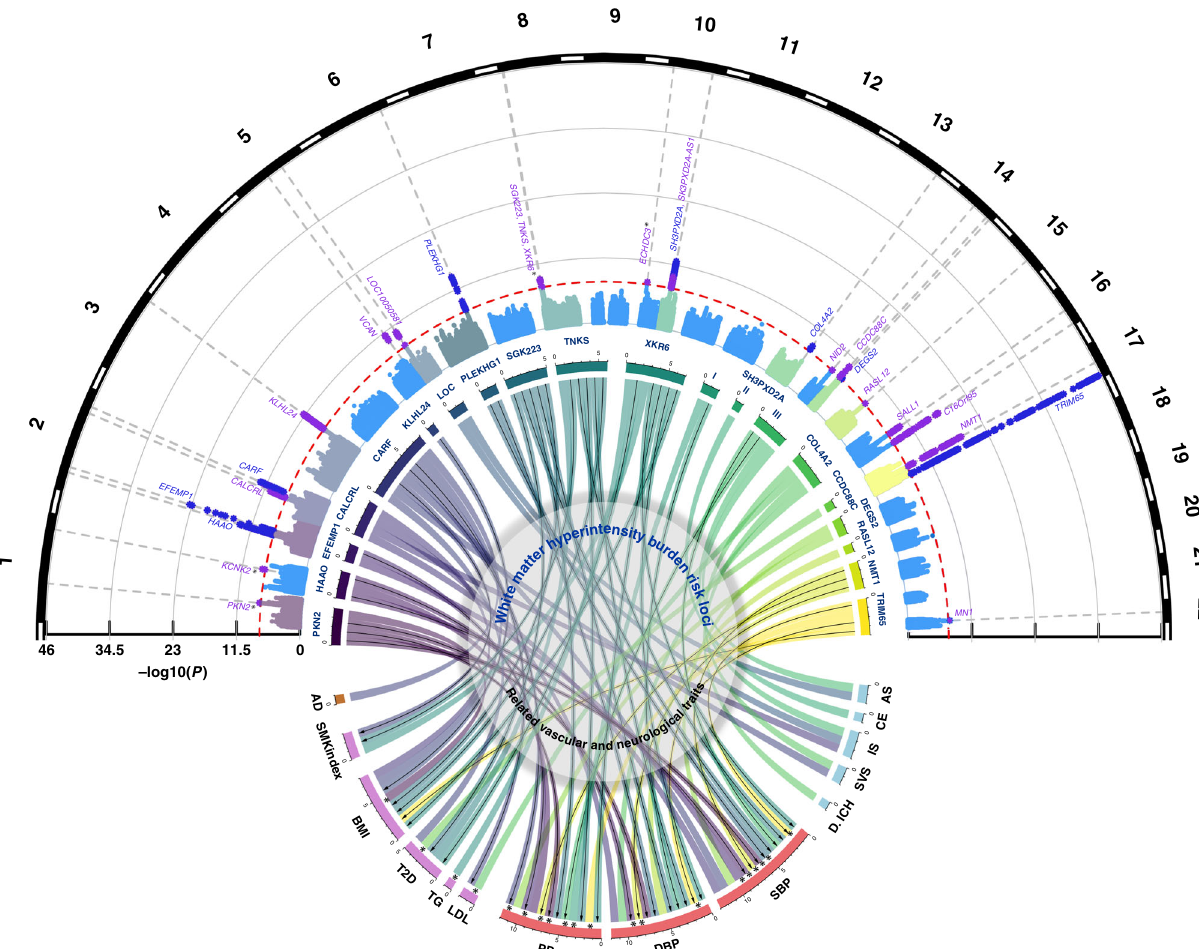
Fig. 2 Genome-wide association results with WMH burden and genetic overlap of WMH risk loci. Circular Manhattan plot (top) displaying novel (violet) and known (dark blue) genome-wide signi fi cant WMH risk loci (dotted line: P < 5 × 10 − 8 ). Asterisks denote association signals that reach genome-wide signi fi cance only in the HTN-adjusted model ( PKN2, XKR6 ) or in the MR-MEGA transethnic meta-analysis ( KCNK2, ECHDC3 ). Chord diagram (center) summarizing the association of genome-wide signi fi cant risk variants for WMH burden (upper section) with vascular and neurological traits (bottom section) ( P < 1.3 × 10 − 4 , see Methods). The width of each of the stems corresponds to the number of traits associated with a given locus (upper section) or the number of loci associated with a given trait. Black arrows indicate genome-wide signi fi cant associations, and asterisks denote SNPs exhibiting unexpected directionality of associations (WMH risk allele displaying protective association with vascular or neurological traits). LOC* LOC100505841, SBP systolic blood pressure, DBP diastolic blood pressure, PP pulse pressure, AS all stroke, IS ischemic stroke, SVS small vessel stroke, CE cardioembolic stroke, ICH intracerebral hemorrhage, AD Alzheimer ’ s disease, BMI body mass index, LDL low-density lipoprotein, VTE venous thromboembolism,